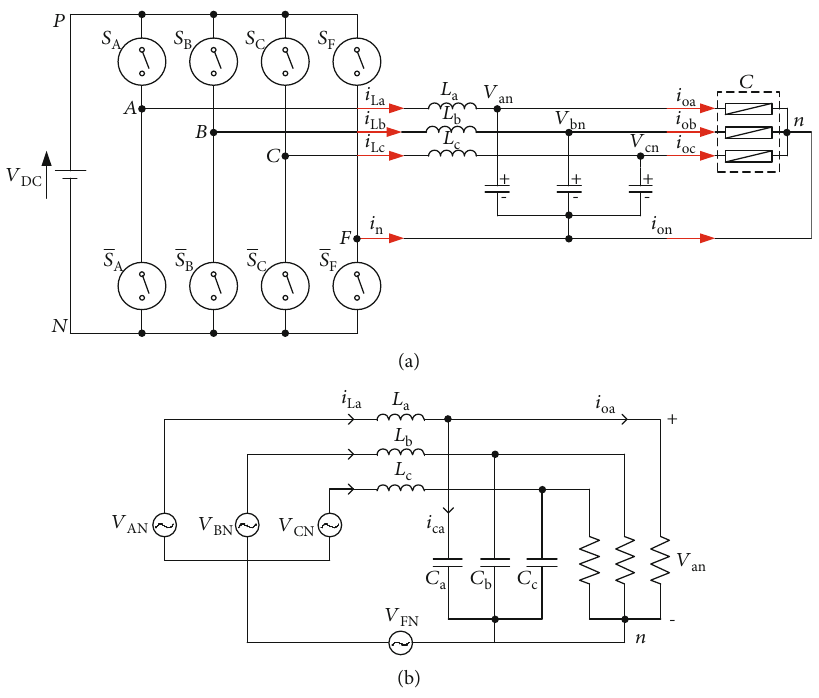
Figure 2: (a) Schematic of the four-leg inverter. (b) Average model of the four-leg